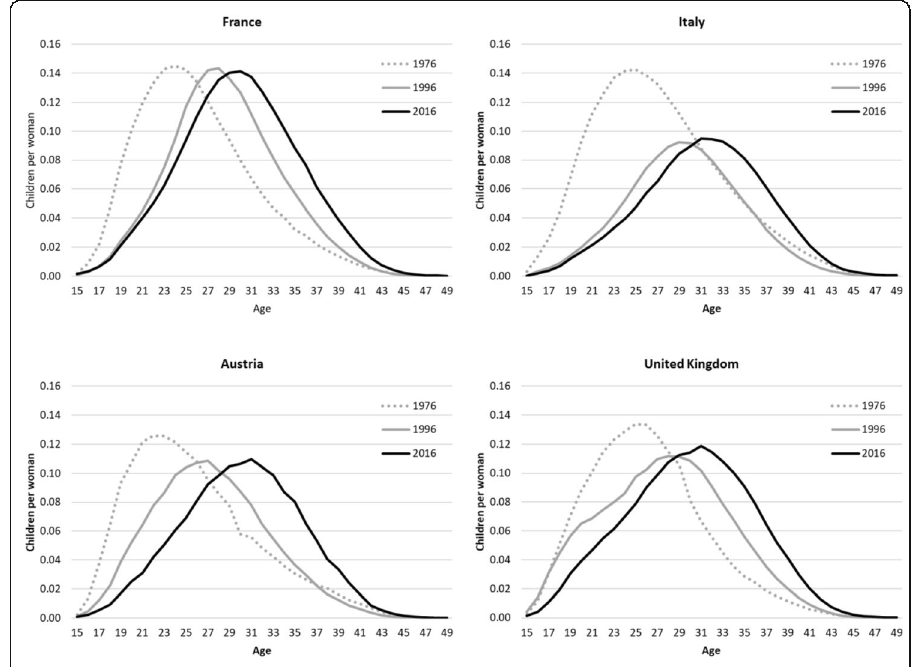
Fig. 3 Age-specific fertility rates in four European countries, 1976, 1996, and 2016. Source: Eurostat